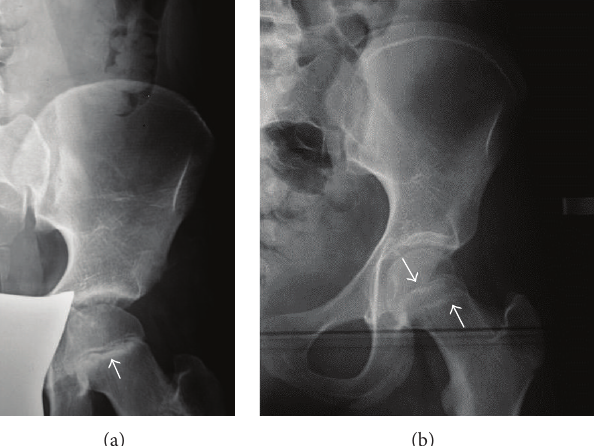
Figure 2: Frontal view of the left hip: (a) three months, (b) two years after bisphosphonate treatment ceased. In (a), dense metaphyseal lines (arrows) in the proximal femur and sclerosis of the acetabular rim were seen. In (b), there was mild sclerosis in both margins of closed physes (arrows). Three layers of bone were evident in iliac wing, with subchondral lucency of the outer layer and two layers in the ischial bone and the